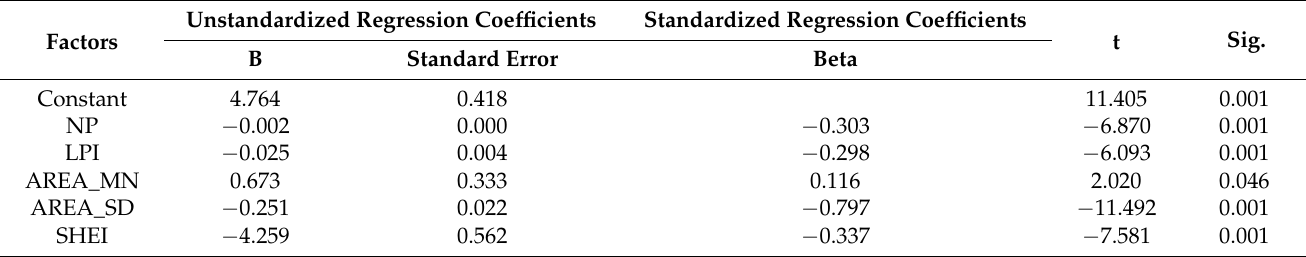
Table 5. Analysis of multiple correlations coefficients of Cotinus coggygria var. cinerea Engl.